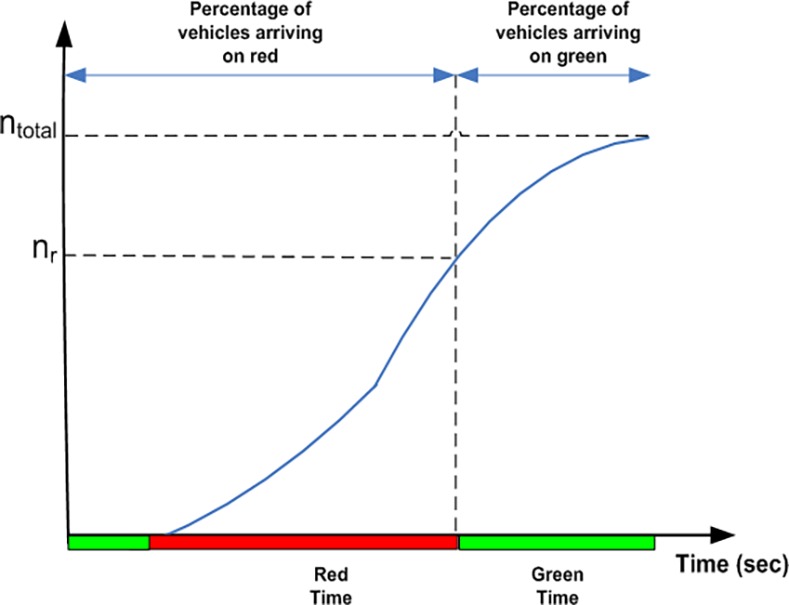
Progression quality.